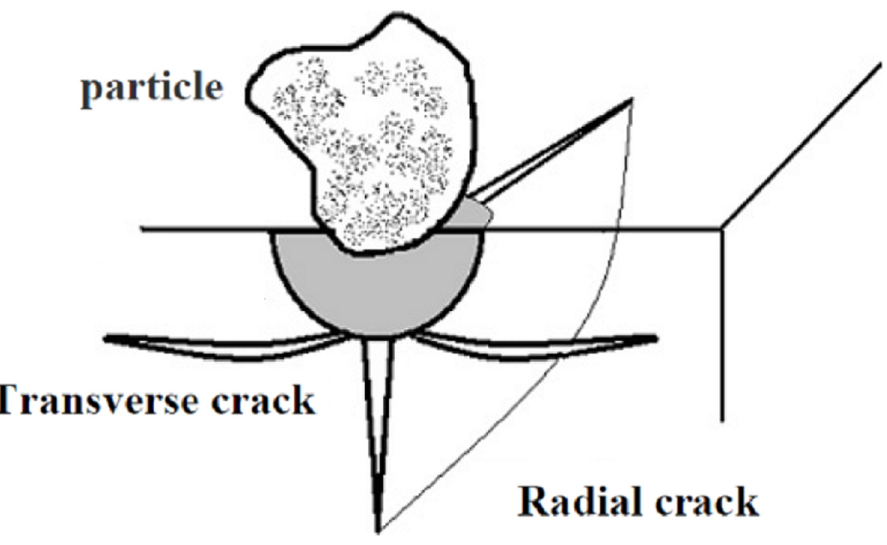
Figure 1. Erosion damage mechanisms of glass [25].